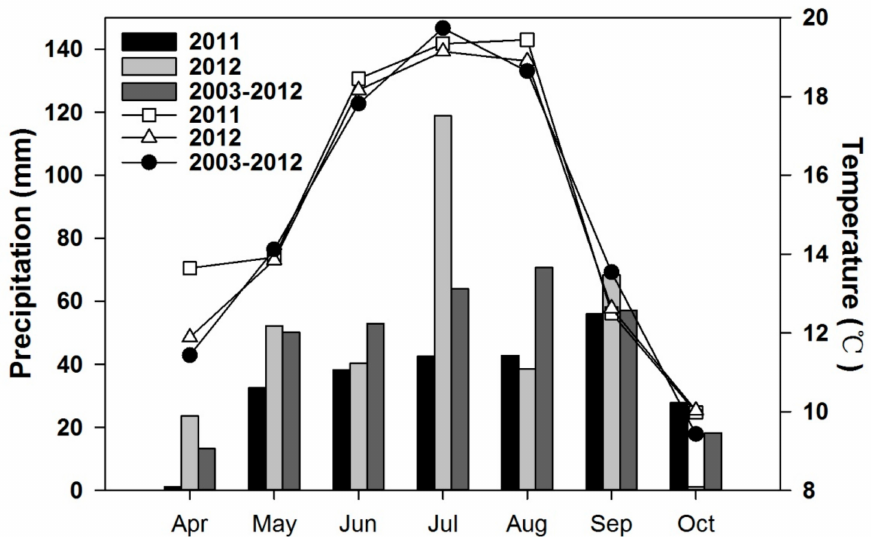
Figure 1. The monthly mean precipitation (mm) and mean temperature ( ◦ C) in 2011, 2012 and 2003–2012 during the growing season (April to October) at the National Meteorological Centre weather station in Yuzhong County, 7.4 km from the experimental